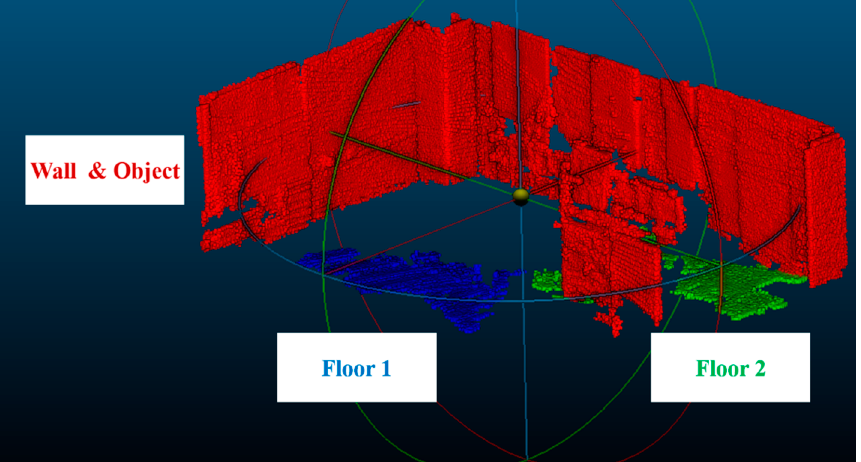
Figure 18. Case of over-segmentation on floor.